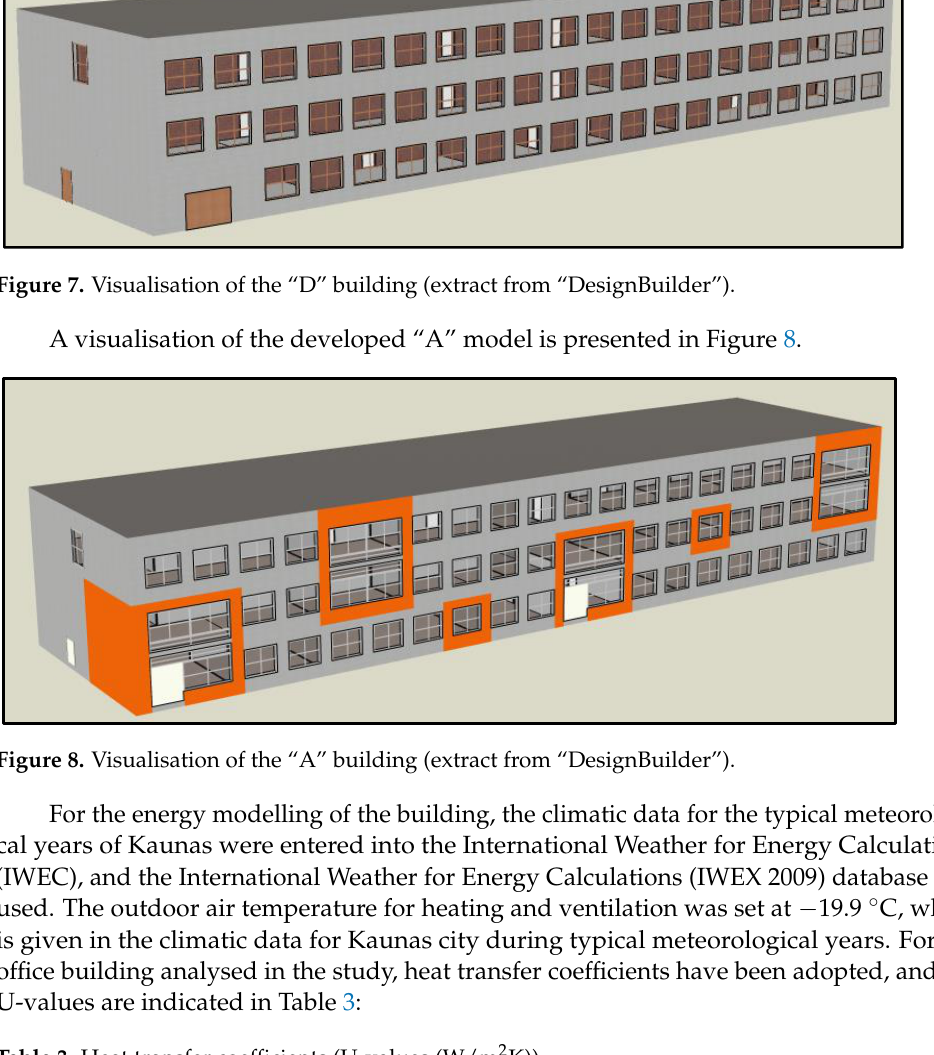
Table 3. Heat transfer coefficients (U-values (W/m 2 K)).